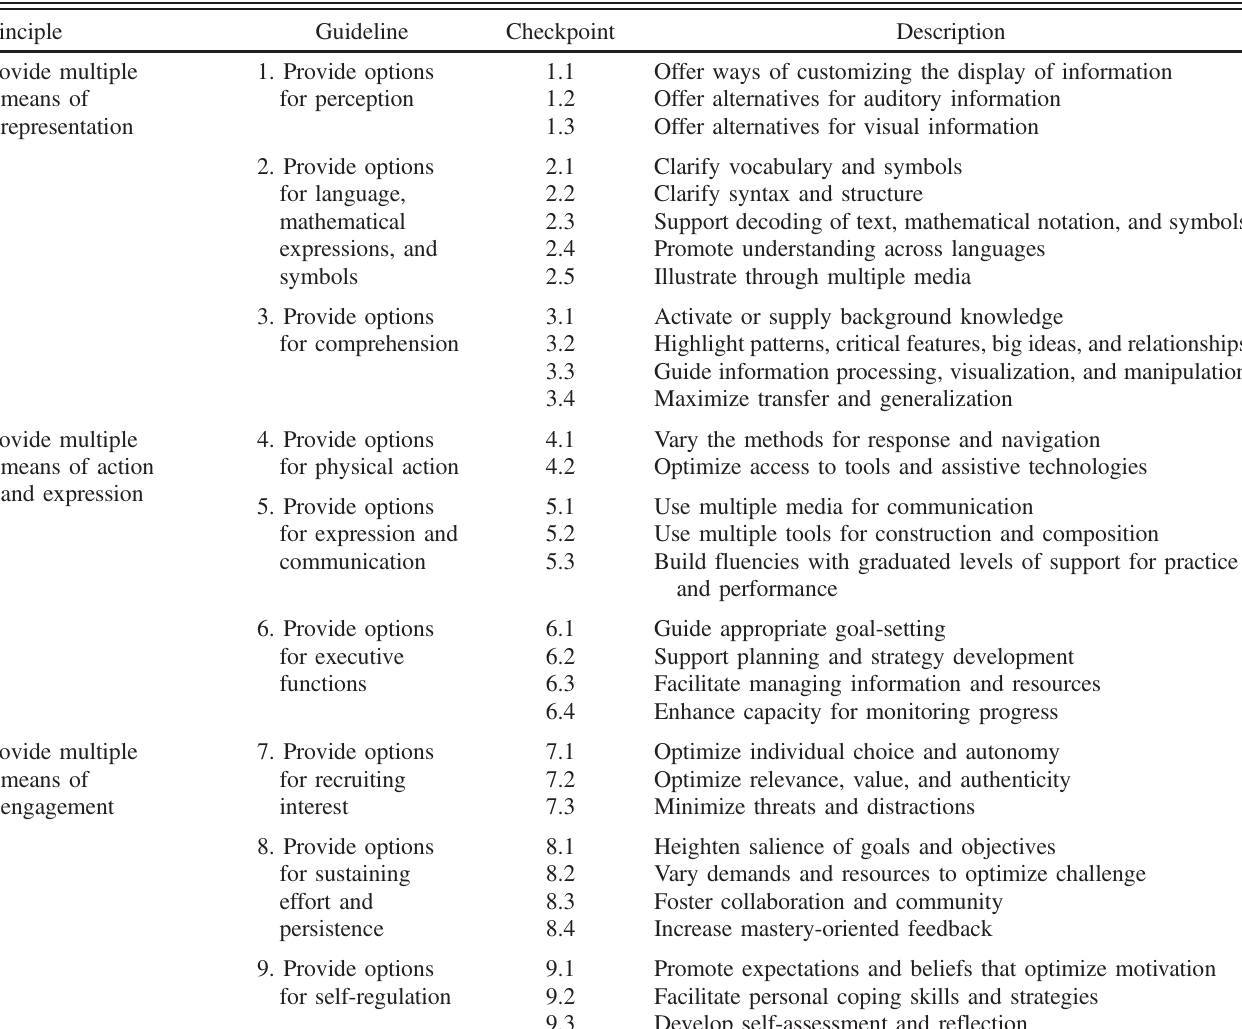
TABLE I. Universal Design for Learning (UDL) guidelines